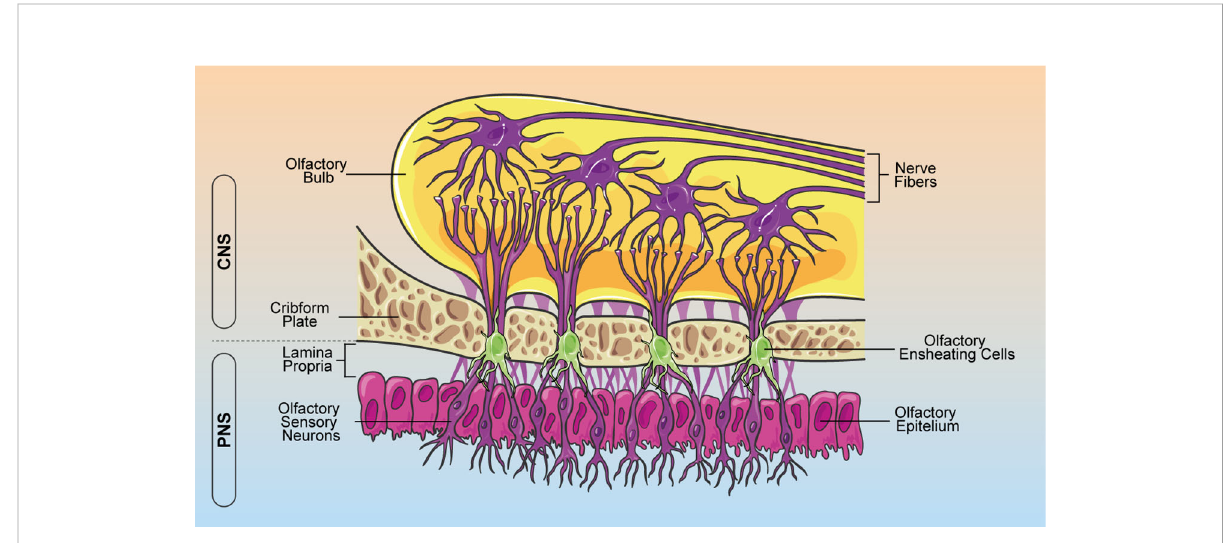
FIGURE 1 Schematic representation of OEC localization within the olfactory system. OECs ensheath bundles of olfactory receptor axons along their course through the lamina propria in the PNS. Olfactory nerves and their associated OECs cross through the cribform plate into the CNS, making connections with the olfactory bulb. OEC, olfactory ensheathing cells; CNS, central nervous system; PNS, peripheral nervous